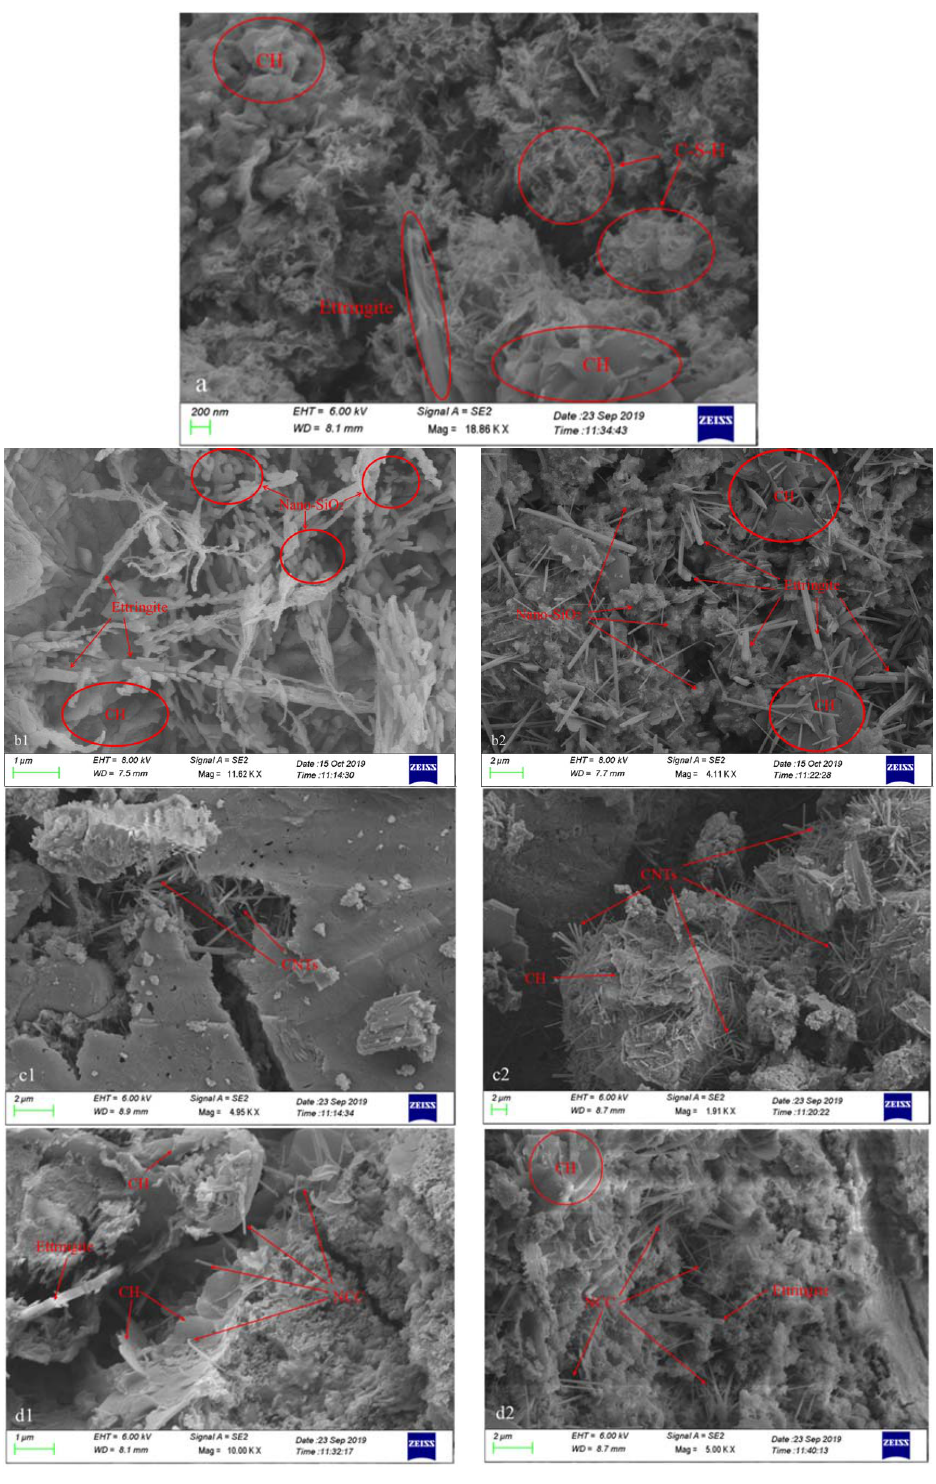
Figure 5. SEM micrographs of cement mortar failure surface at age of 28 d: ( a ) blank group; ( b1 ) 2% nano-SiO 2 ; ( b2 ) 3% nano-SiO 2 ; ( c1 ) 0.1% CNTs; ( c2 ) 3% CNTs; ( d1 ) 0.5% NCC; ( d2 ) 3%